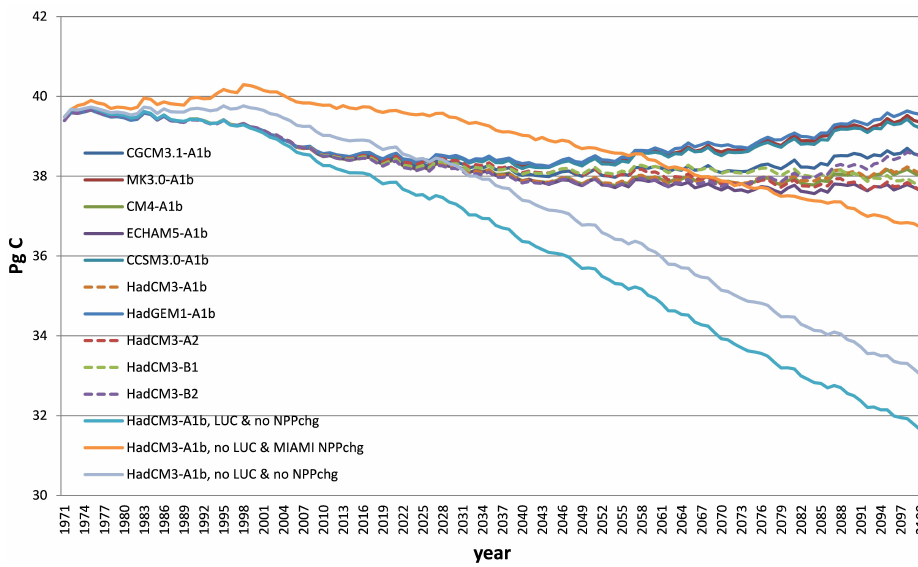
Fig. 8. Dynamic of total SOC changes aggregated over the region of NW Pacific and E Asia of all simulations (see text for further details).